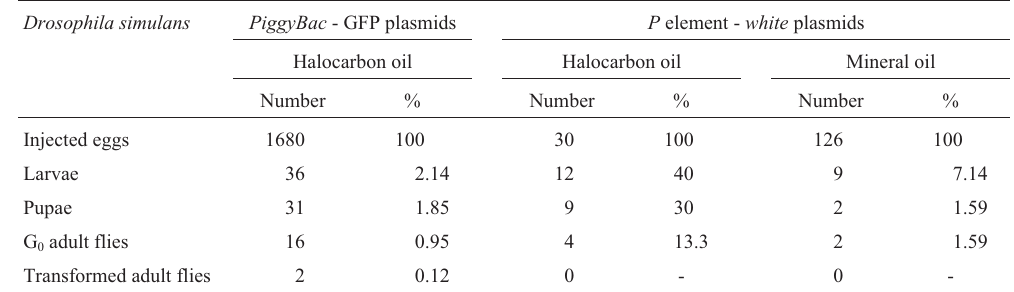
Table 1 - Number and frequency of injected eggs and other developmental stages of Drosophila simulans injected with piggyBac and P element plasmids. Drosophila